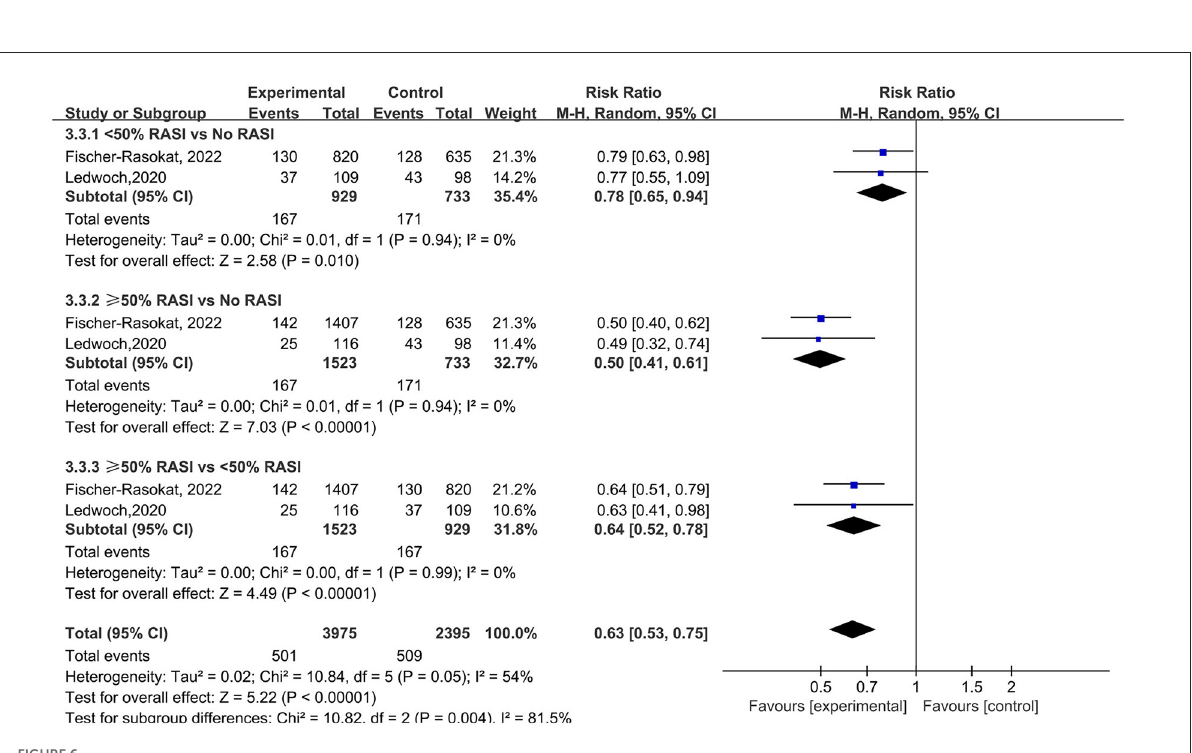
FIGURE6 Forest plots of random-effects meta-analysis for the rate of all-cause mortality by subgroups of the dose of RAS